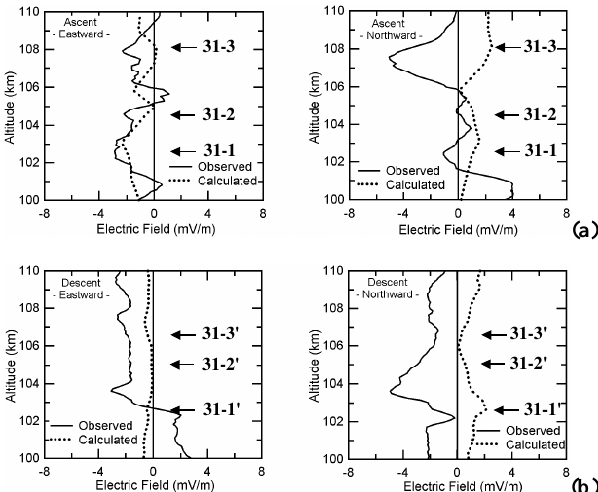
Fig. 4. Comparison between the observed electric fields and those calculated using Eq. (11). In the two panels (a) , the observed and calculated profiles are similar in the eastward component though the northward component, disagrees especially around the 106–109km altitude. The E s layers (detected by S310-31 during ascent) are in the altitude ranges where the electric fields are shifted to south- west. During the descending phase, panel (b) , the electric fields are displaced in the direction of westward and southward, particularly above the altitude of 103km.